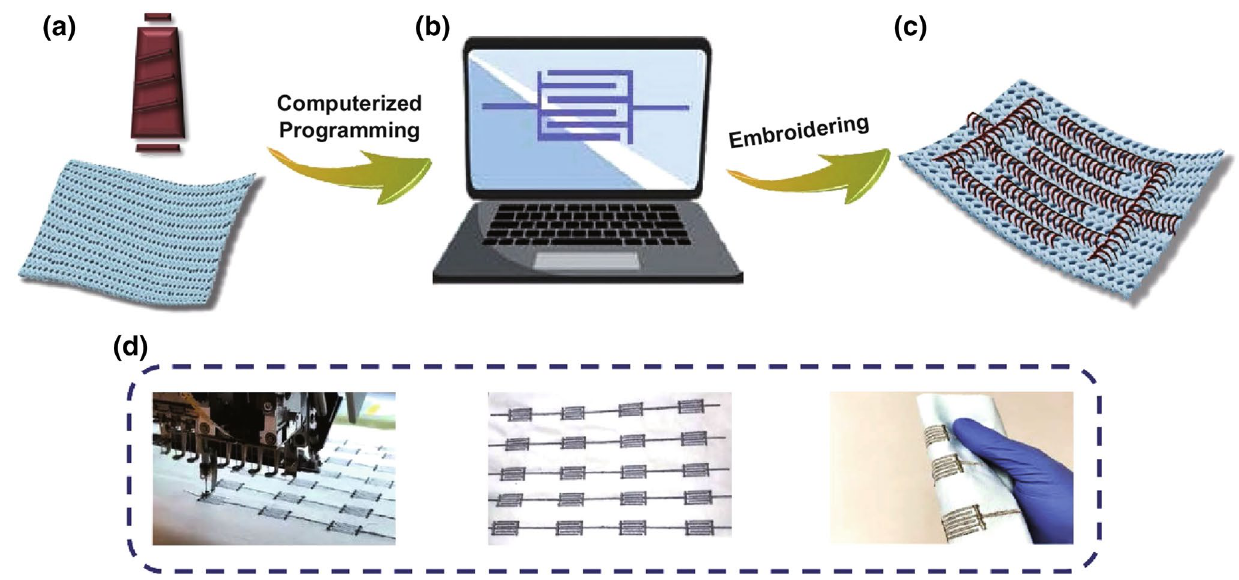
Fig. 1 a Schematic diagram of a cone of the conductive silver-plated nylon yarns and a piece of the cotton fabric. b Diagram of the computer- aided programming. c Diagram of the conductive SE. d Real photographs of the SE